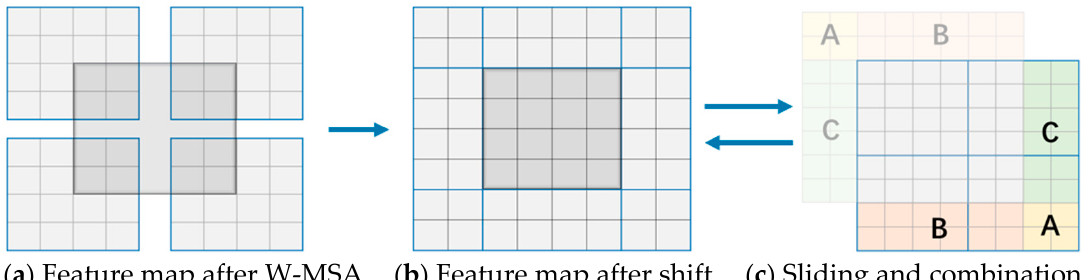
Figure 7. Shifted Windows Multi-Head Self-Attention mechanism. ( a ) The feature map under the W-MSA mechanism; ( b ) the feature map after the shift; ( c ) the self-attention calculation method in SW-MSA using the mask mechanism.